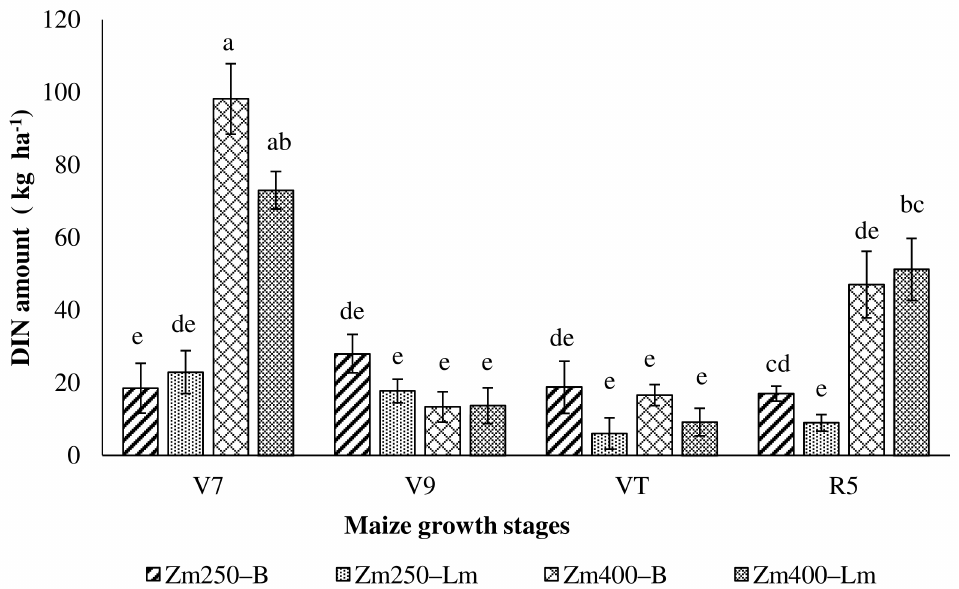
Figure 6. Amounts of dissolved inorganic N (DIN) present in leachates at the V7, V9, VT, and R5 stages of the maize crop. Different letters in the bars indicate statistically significant differences between the treatments based on multiple LSD Fisher comparisons ( α ≤ 0.05), including standard deviation error